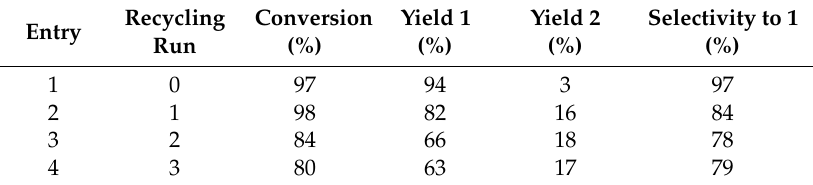
Table 4. Recycling of Pd/GO-TiO 2 in the carbonylative Suzuki–Miyaura cross-coupling reaction a . Recycling Conversion Yield 1 Yield 2 Selectivity to 1 Entry Run (%) (%) (%) (%) 0 97 94